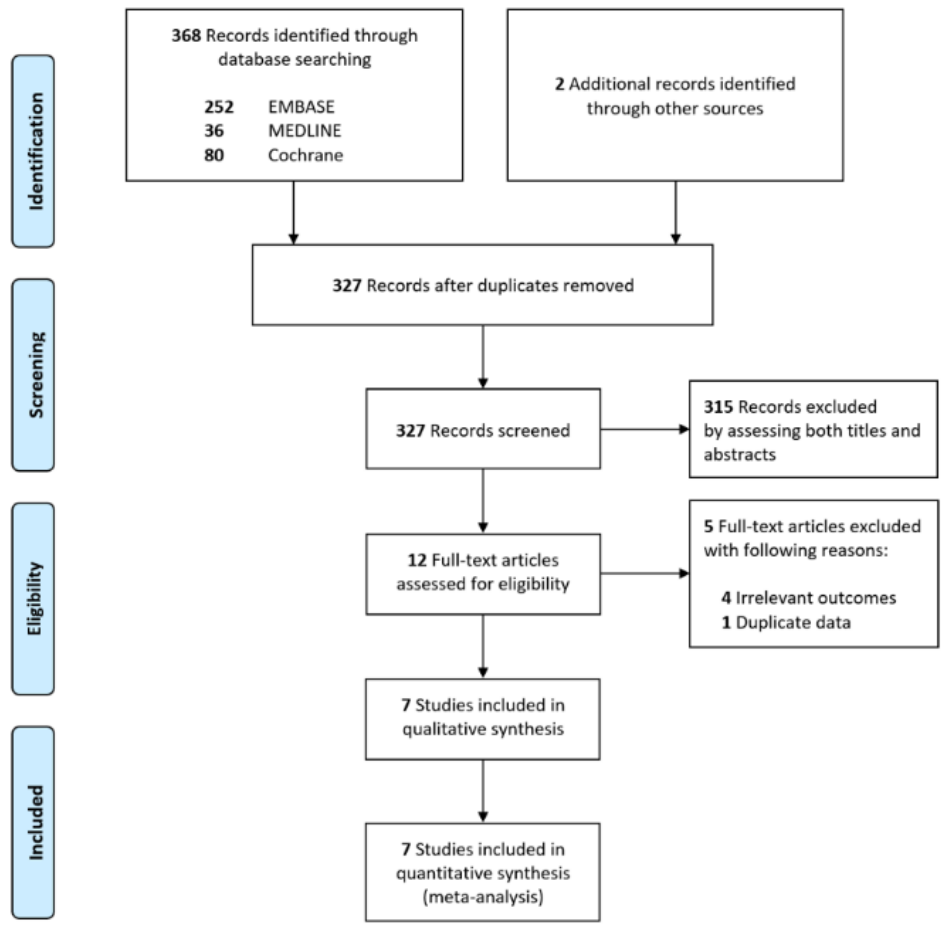
Figure 1. Flow diagram for the identification of relevant studies.